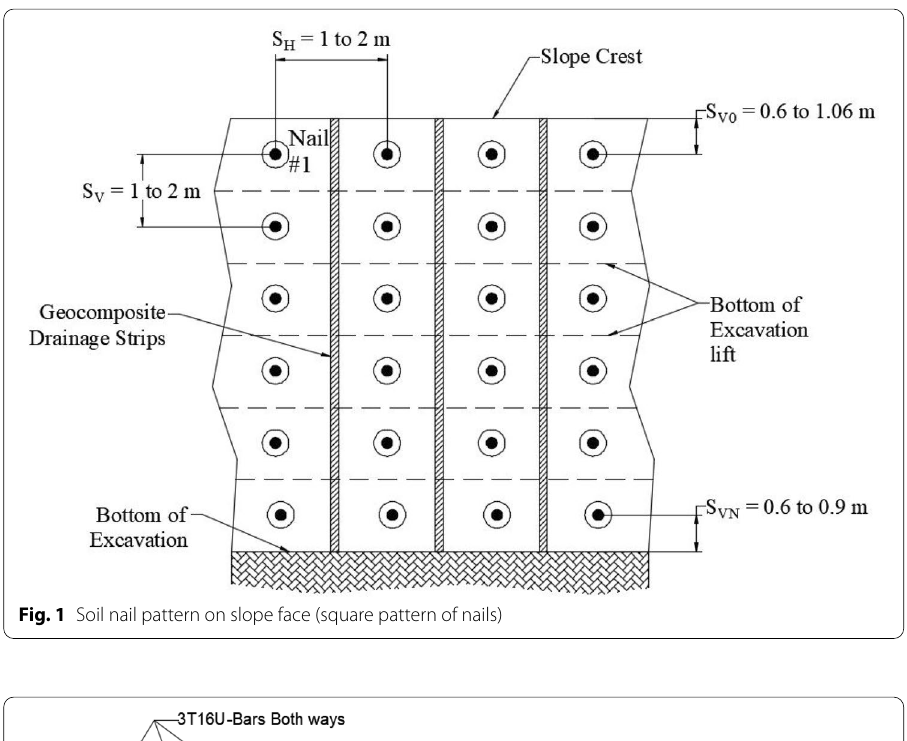
Fig. 1 Soil nail pattern on slope face (square pattern of nails)